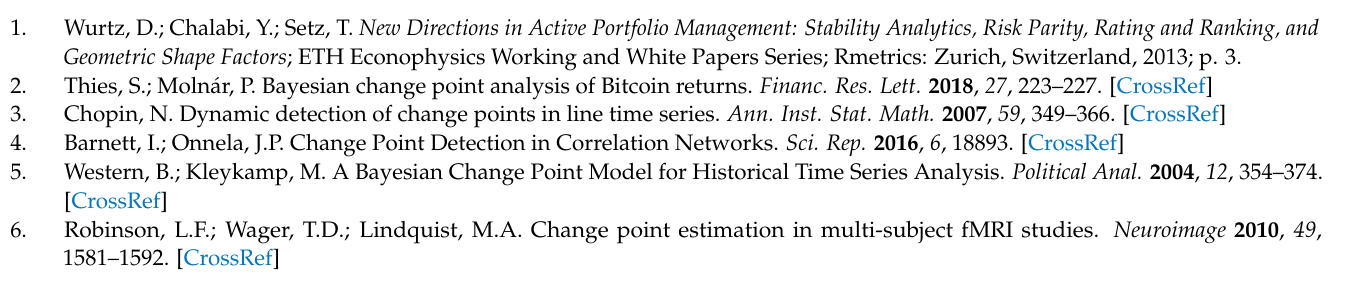
based on the entire dataset rather than short subsegments of the data, then the